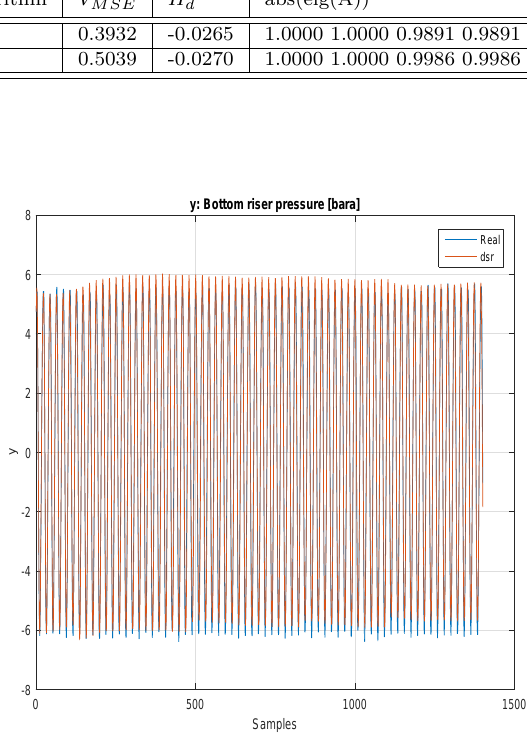
Figure 14: Illustration of the identified model DSR 8 Eq. (18) simulated over the identification set resulting in V MSE = 0 .